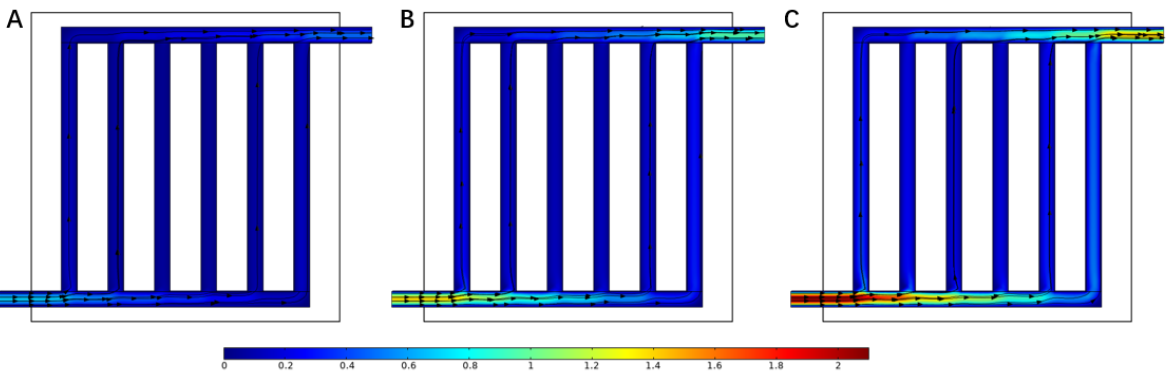
Figure 6. Velocity distribution in the flow field under different current densities: ( A ) 0.5 A cm − 2 , ( B ) 1.0 A cm − 2 , and ( C ) 1.5 A cm − 2 .